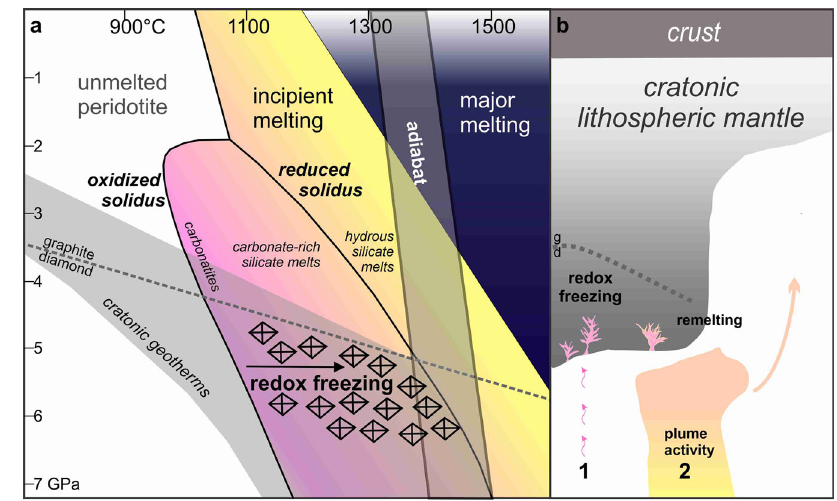
Fig. 1 Incipient melts in lower cratonic settings. a Melting curves of peridotite in oxidized and reduced conditions in theincipient melt regime. Oxidized melts freeze in the reduced lithosphere, depositing diamonds as the local solidus increases in temperature as it evolves from a carbonate solidus to a reduced solidus (black arrow). The region of diamond formation is marked with diamond symbols 18,19 . Pink and peach areas indicate carbonatitic, and carbonate-rich silicate melt; yellow areas have hydrous silicate melts. Dashed line: graphite-diamond boundary 46 . Cratonic geotherms (35 – 45mW/m 2 47,48 ). Temperature range of mantle adiabat based on mantle potential temperatures of 1300 – 1400°C. b schematic relationship of the cratonic lithosphere and incipient melt metasomatism. 1: the gradual in fl ux of carbonate-rich incipient melts freezes in the base of the cratonic lithosphere, depositing diamonds by redox freezing 8,17 . 2: Later reheating of the lowermost metasomatized cratonic lithosphere induces re-melting of the metasomatized rocks 8